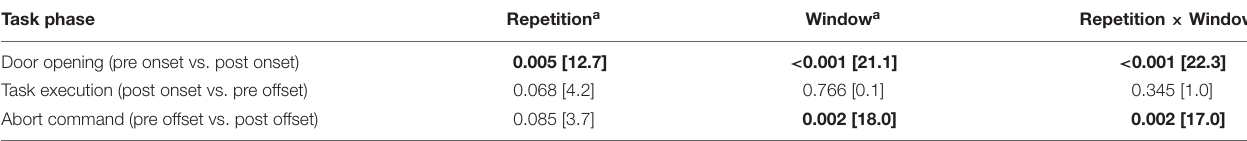
TABLE 4 | Effects on the heart rate of performing repeated tasks. Task phase Repetition a Window a Repetition × Window a